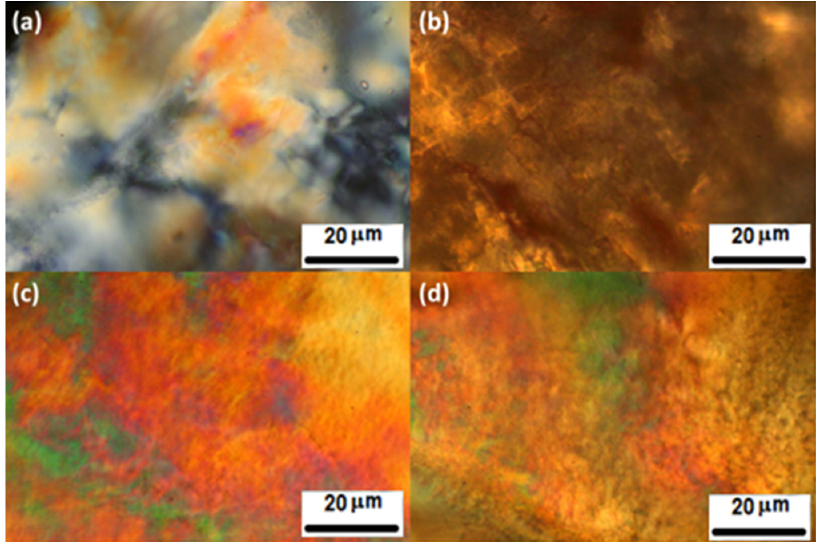
Figure 3. Photomicrographs of ( a ) polymer 1 at 30 wt% in DMSO, ( b ) polymer 2 at 20 wt% in CH 3 CN, ( c ) polymer 3 at 30 wt% in CH 3 CN, and ( d ) polymer 5 at 40 wt% in MeOH under crossed polarizers exhibiting lyotropic liquid-crystalline (LC) phase, respectively (magnification 400 × ).